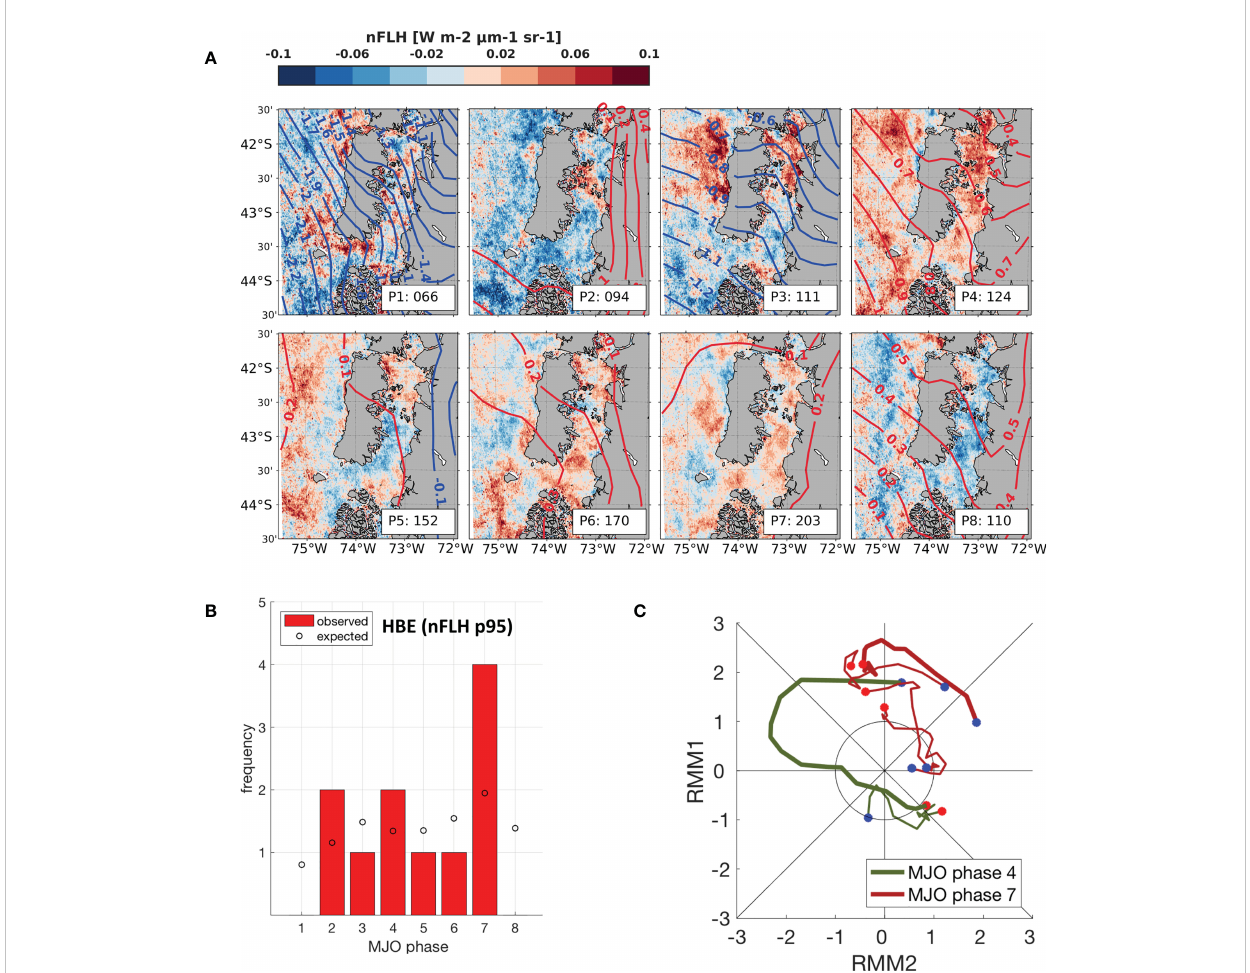
FIGURE 6 (A) Composite of nFLH ’ (SY-IS anomalies, red/blue shaded for positive/negative values [W m -2 µm -1 sr -1 ]; see colour scale) and MSLP ’ (SY-IS anomalies, red/blue contours for positive/negative anomalies every 0.1 hPa) for active MJO phases (RMM index amplitude greater than 1; reference period: DJF 2003-2019); the box in the lower right corner of each panel indicates the respective MJO phase and the number of days used in the composite. (B) red bars: Histogram of the 11 observed HBEs for which the corresponding day 0 coincides with an active MJO phase, grouped by MJO phases. The empty circles show the expected frequency of 11 events if they followed the climatological distribution of active MJO phases for DJF 1975-2020. (C) Trajectories in the MJO RMM diagram for each HBE whose day 0 occurred on active MJO phases 4 and 7 (green and brown curves, respectively); day 0 and day -14 are identi fi ed by a red and blue circle, respectively. The bold curves indicate the trajectories of the two case studies culminating respectively on January 19, 2019 (MJO active phase 4, green curve) and January 23, 2013 (MJO active phase 7, brown